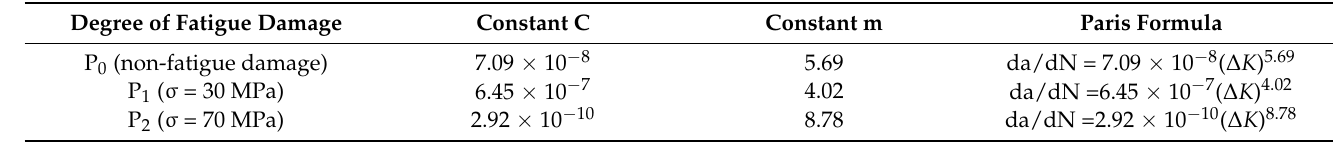
Table 4. Paris formula fitting results.